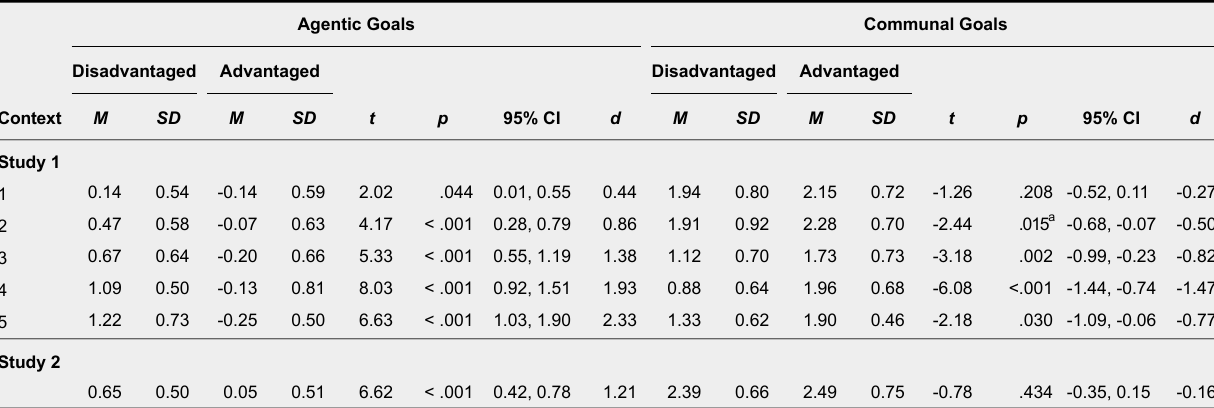
Means and Standard Deviations of Agentic and Communal Goals and Effect Sizes of the Social Role Manipulation (Study 1 [Contexts 1-5], and Study